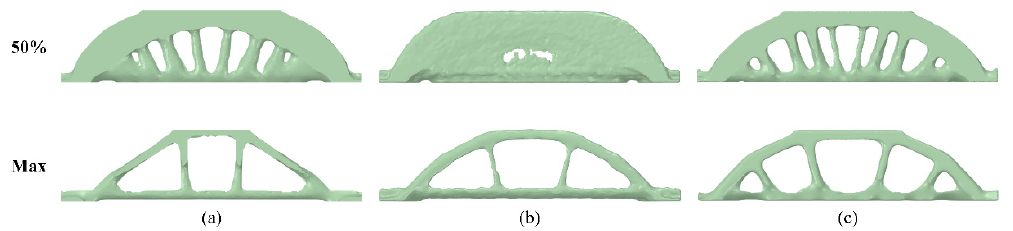
Figure 10. The optimized designs of the bridge for 50% and maximum weight reduction in ( a ) SolidWorks, ( b ) ANSYS Mechanical, and ( c ) ABAQUS.